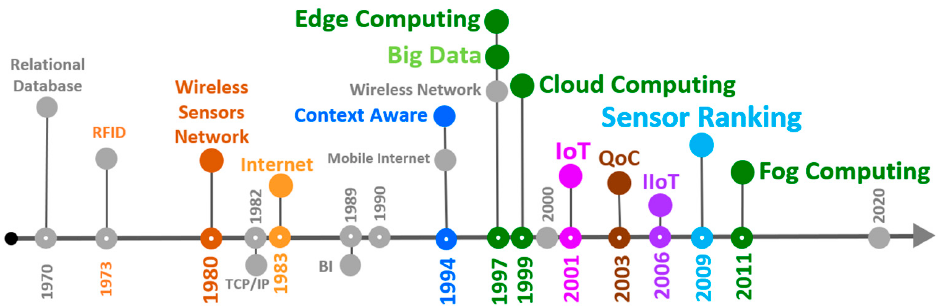
Figure 1. Technologies related to the growth of digital data.